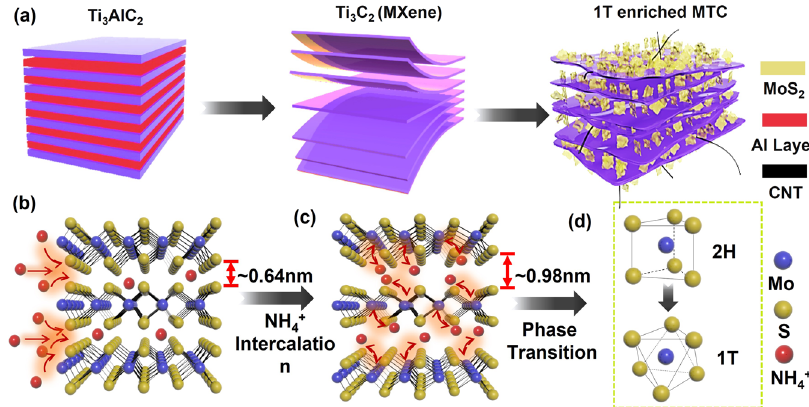
Fig. 1 Schematic illustration of sample preparation. a Schematic illustrations of the preparation of 1 T enriched-MoS 2 /MXene/CNT composite through one-step solvothermal technique. The mechanism of ammonia ion intercalation induced MoS 2 phase transition is shown in b – d